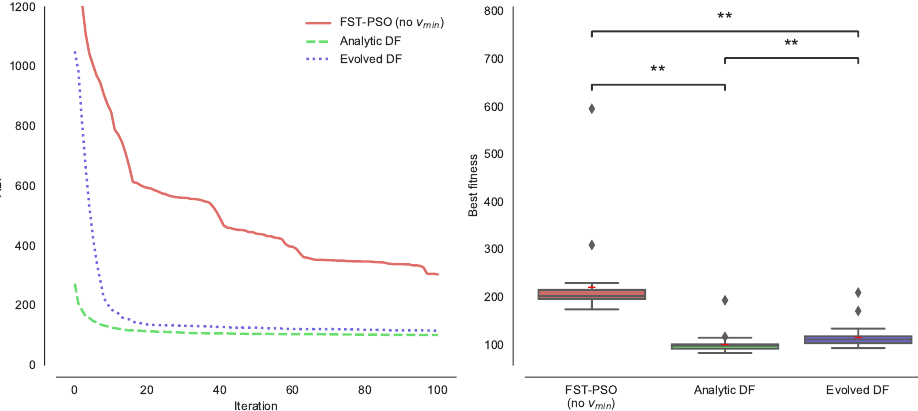
Figure 7. ( Left ): convergence plot of the PE of the MM model obtained with FST-PSO (no v min ) (coral solid line), FST-PSO using the analytic DF (green dashed line), and FST-PSO using the evolved DF (blue dotted line). The lines correspond to the ABF calculated over 30 runs. ( Right ): boxplots representing the distributions of the best solutions found at the end of each run, for each methodology; red dashes denote the mean of the distributions, while diamonds denote the outliers. The asterisks denote the p -values obtained by comparing the distributions by means of the Mann–Whitney U tests ( ** p -value ≤ 0.0001).